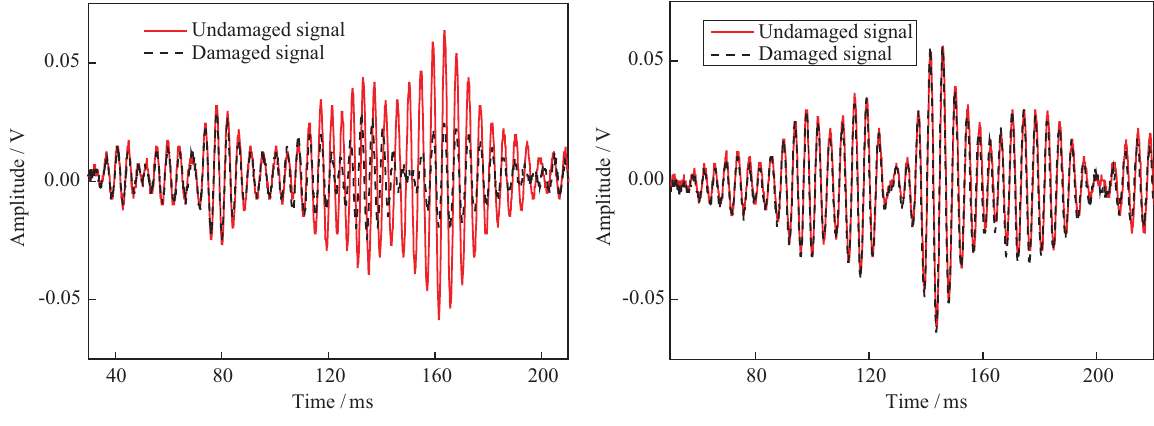
Fig. 5. Lamb wave signals in the path S2–S10. Fig. 6. Lamb wave signals in the path